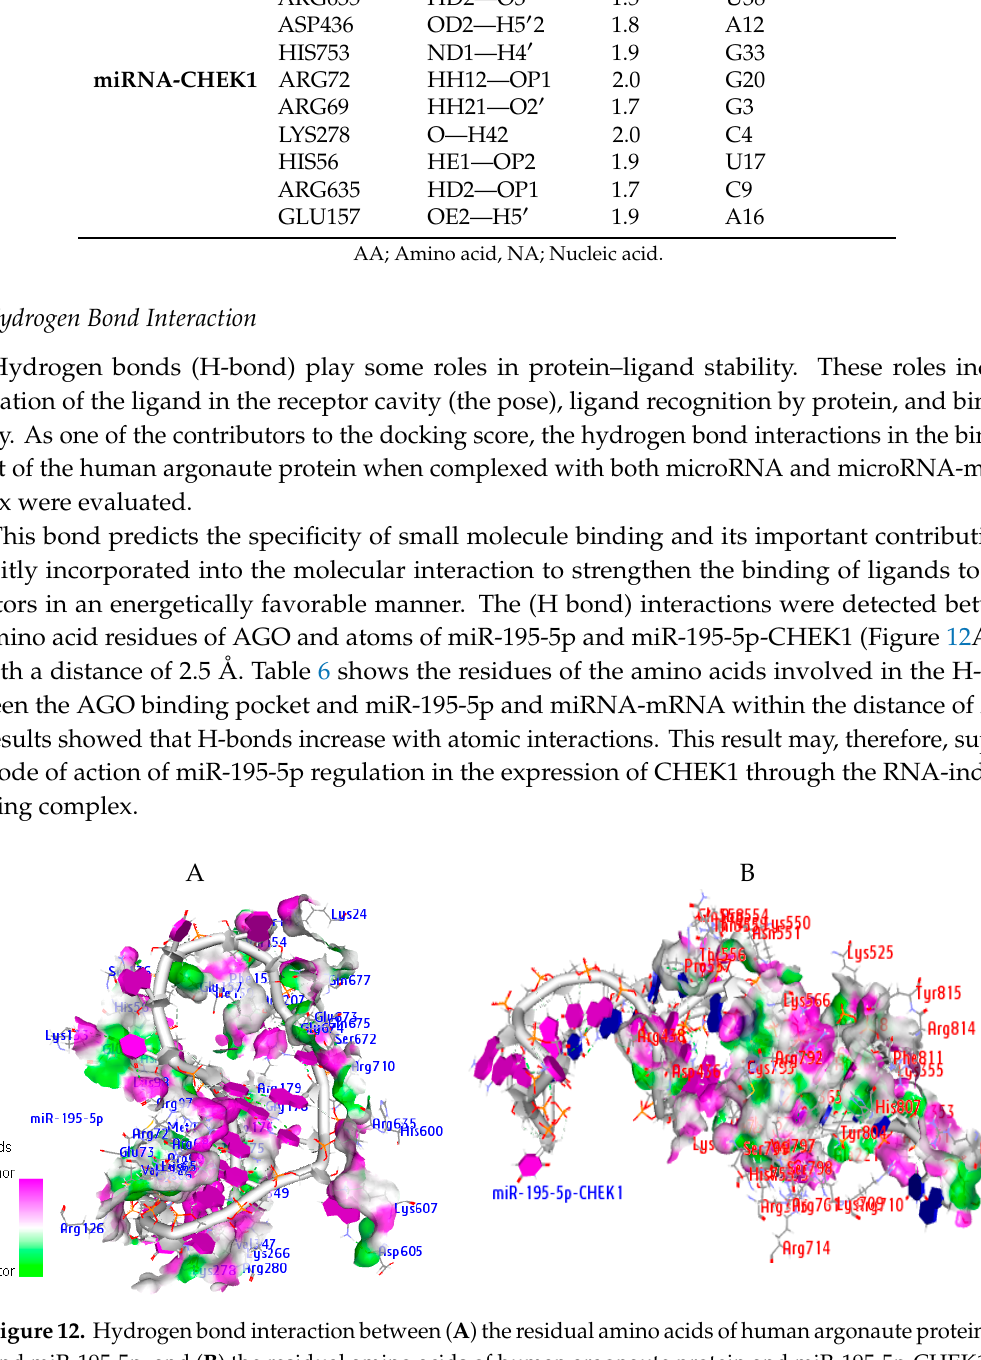
Figure 12. Hydrogen bond interaction between ( A ) the residual amino acids of human argonaute protein and miR-195-5p, and ( B ) the residual amino acids of human argonaute protein and miR-195-5p-CHEK1 duplex (3.5 Å distance).